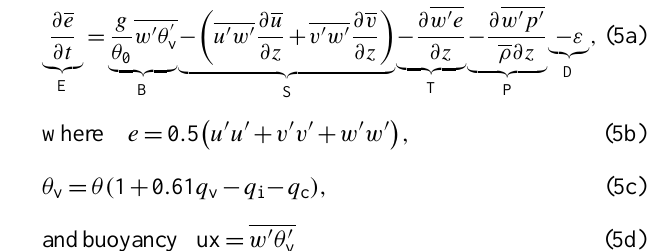
Table 2. Constants used in this